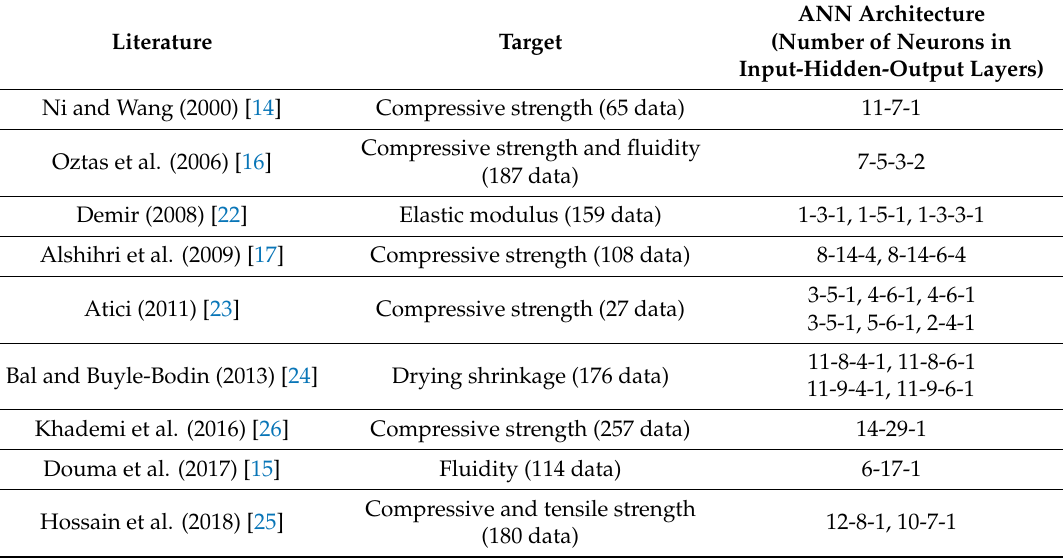
Table 1. Previous studies using artificial neural network (ANN) analysis for predicting mechanical behavior of cement-based